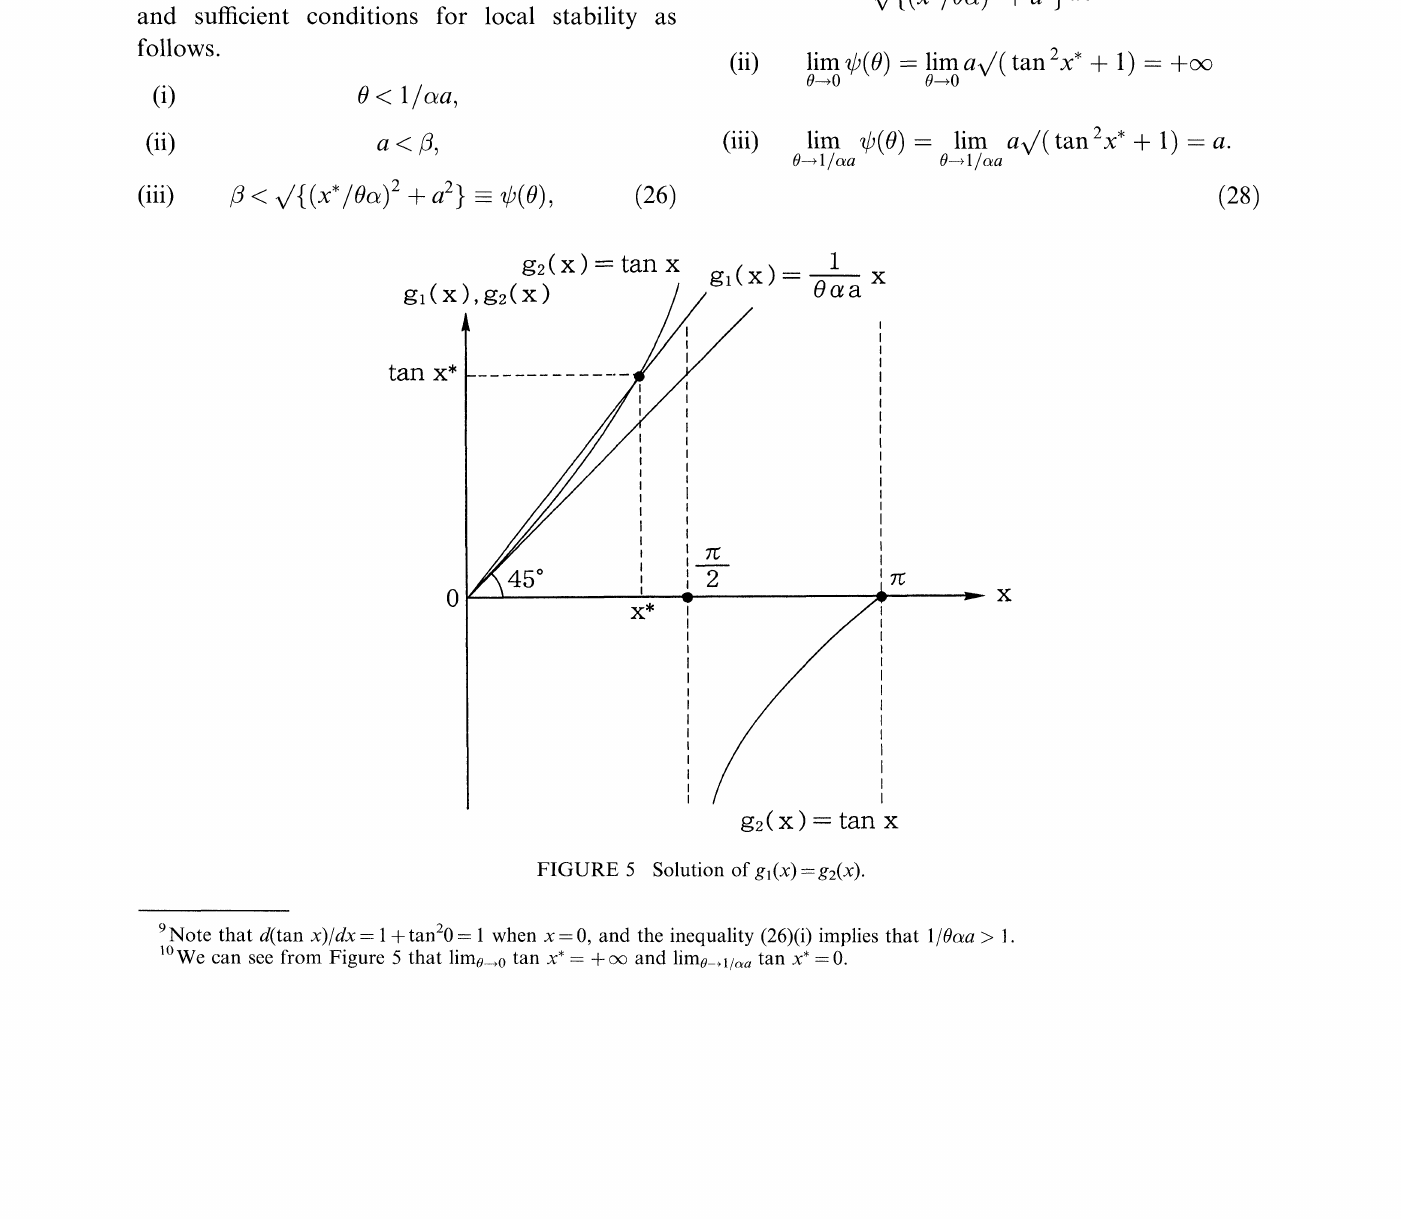
FIGURE 5 Solution of